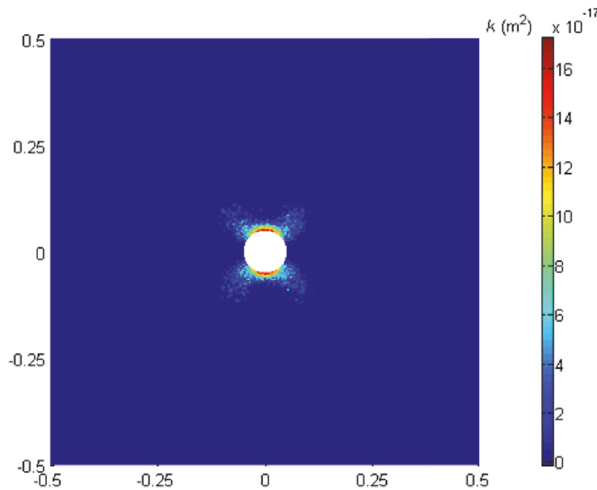
Figure 14: Permeability distribution under lateral pressure coeffi- cient 𝜆 𝜎 = 3